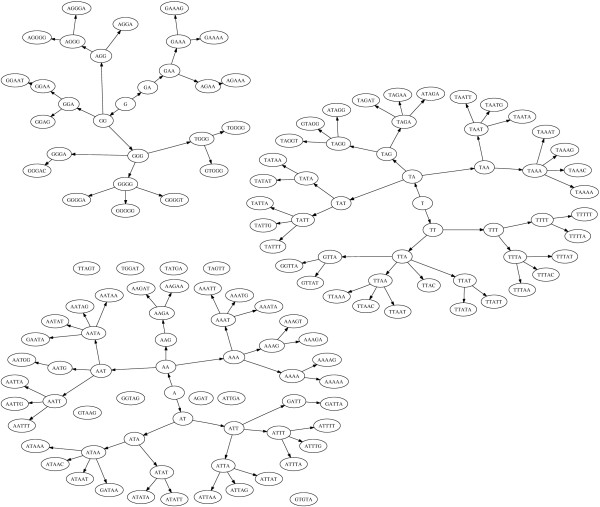
Subword Structure of Ineffective Subword-unique Motifs. A subword tree constructed in the same manner as Figure 3, but for motifs associated with ineffective antisense suppression. In this population of motifs, nodes are grouped into two main trees, one rooted with "A", one rooted with "T". Surprisingly, despite the lower Gibbs free energy associated with its presence, a third tree rooted at "G" was found within this population of motifs as well.